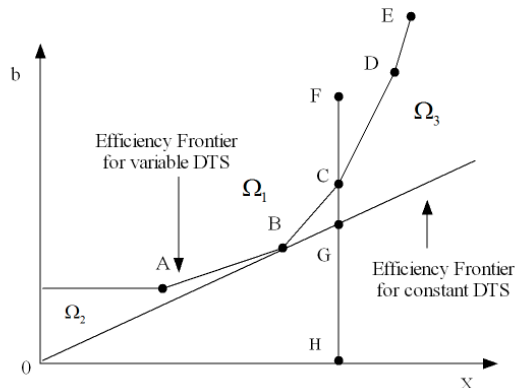
ffi ciency frontier of undesirable outputs under variable DTS and invariable Figure 2. Efficiency frontier of undesirable outputs under variable DTS and invariable DTS. Figure 2. E